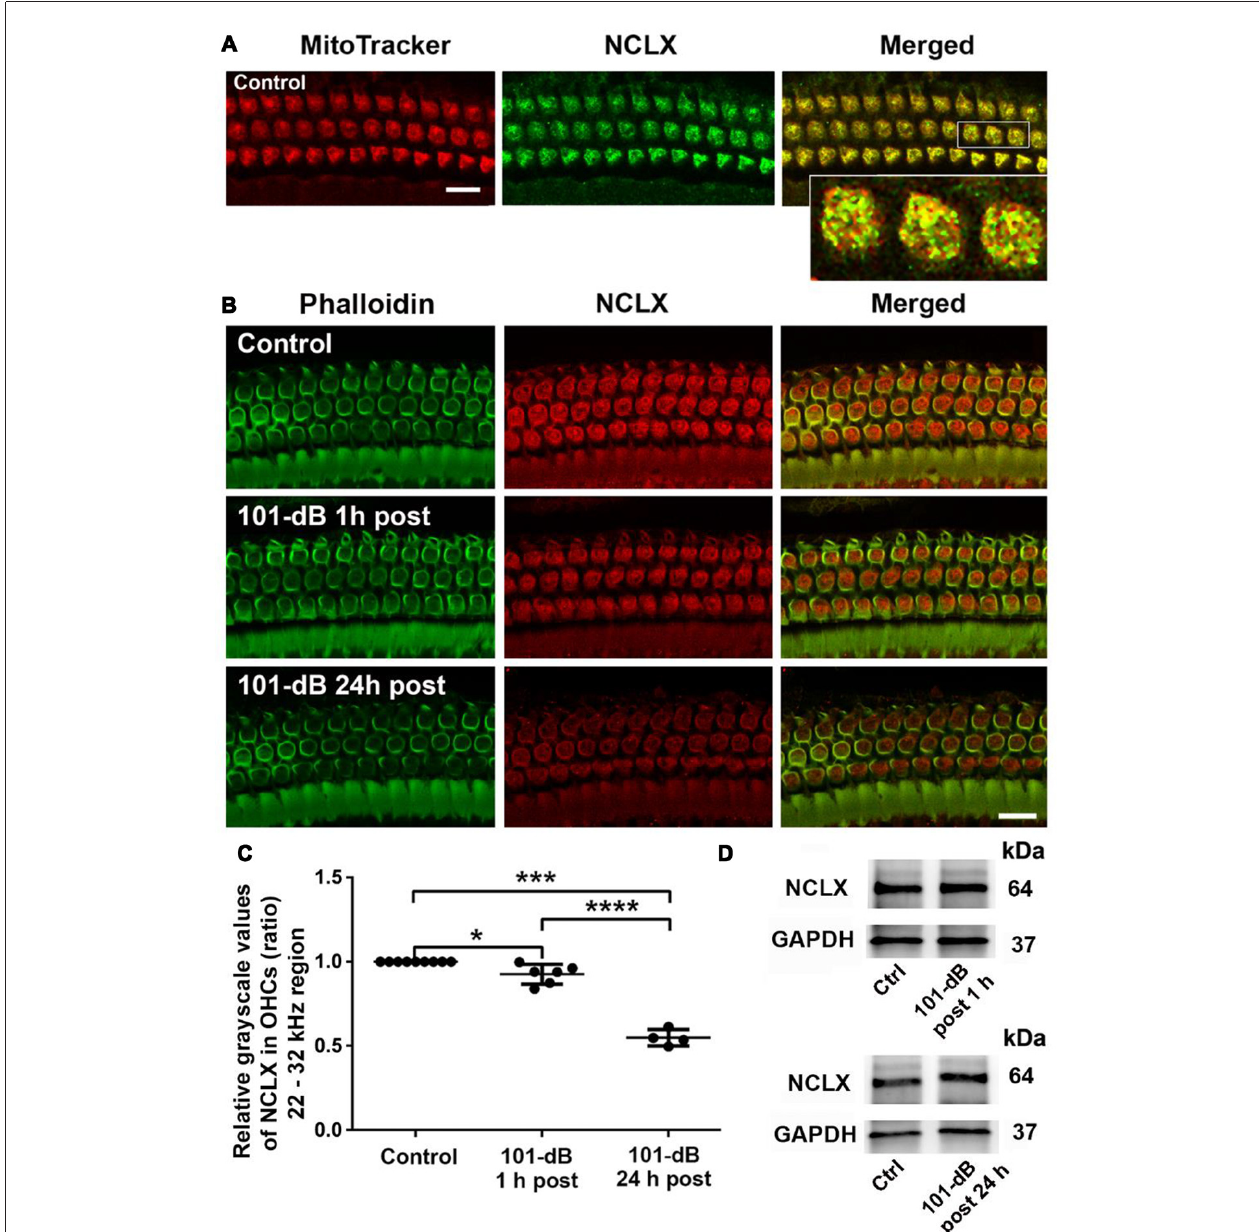
FIGURE 4 | Noise exposure decreased NCLX immunoreactivity in OHCs of the basal turn in a time-dependent and intensity-dependent manner. (A) Representative images of surface preparations revealed co-localization of NCLX (green) and MitoTracker (red) in OHCs (merged, yellow). An enlarged image of three OHCs better illustrates the co-localization; scale bar = 10 µ m, n = 3 per group with one cochlea used per mouse. (B) Representative images for NCLX in OHCs 1 h and 24 h after completion of the exposure. Green: phalloidin-stained OHCs. Images were taken from the 22–32 kHz region of the surface preparations using a Leica SP5 confocal microscope; scale bar = 10 µ m. (C) Quantitative analysis of NCLX immunolabeling in OHCs showed a significant decrease in a time-dependent manner. Data are presented as individual points and means ± SD; ∗ p < 0.05, ∗∗∗ p < 0.001, ∗∗∗∗ p < 0.0001. Control: n = 9, 101-dB 1 h post: n = 6, 101-dB 24 h post: n = 4 with one cochlea used per mouse. (D) Representative immunoblots of total cochlear homogenates from CBA/J mice showed no difference in NCLX band densities between control and noise exposed mice when examined 1 h and 24 h after completion of the exposure. GAPDH served as the sample loading control; n = 6 mice per group.